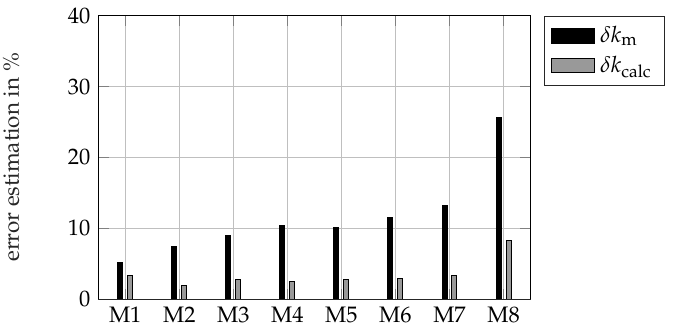
Figure 14. Relative predicted error of the measured values of the thermal conductivity δ k .